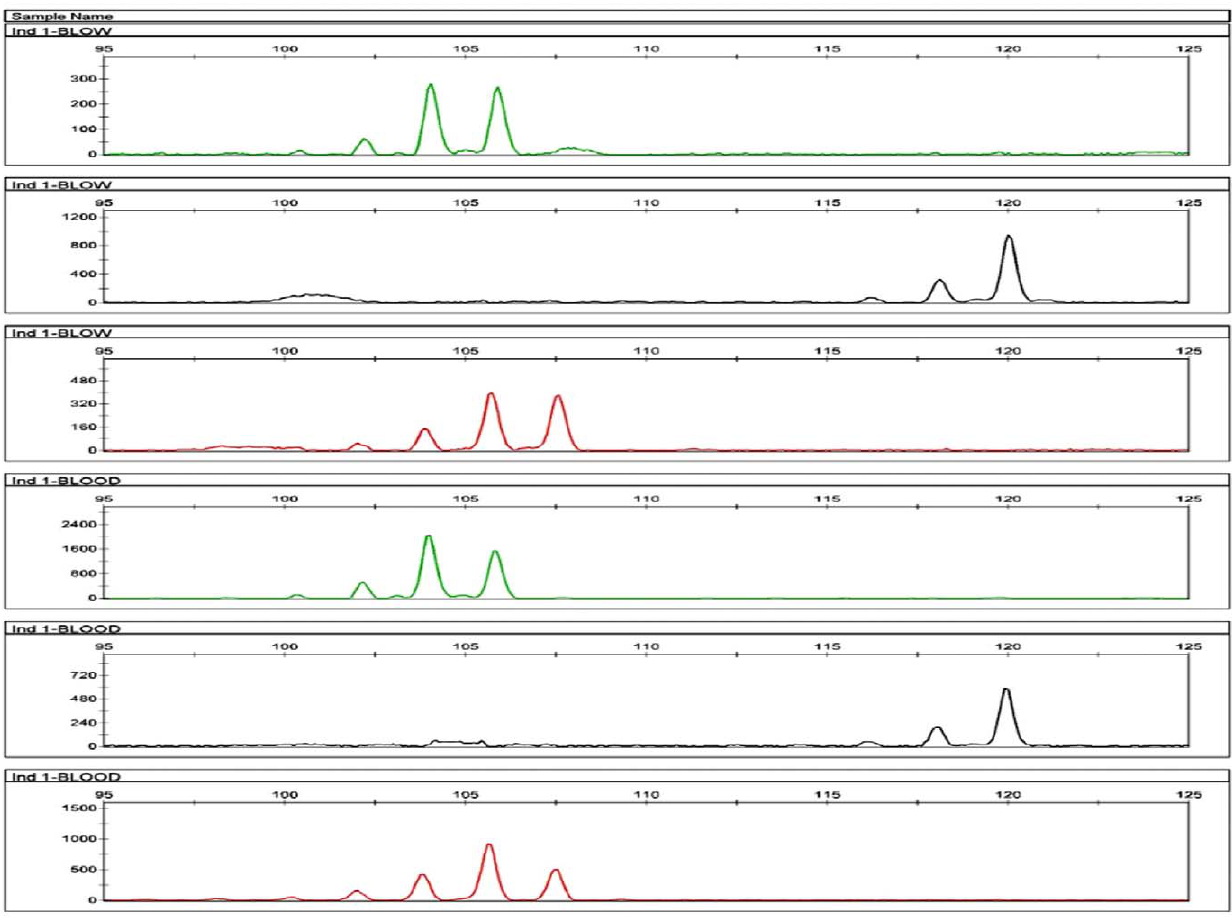
Figure 2. Microsatellite DNA profile of blow and blood from individual 1. To estimate whether the microsatellite profile collected from an individual’s blow matched the microsatellite profile collected from its blood, we amplified 3 polymorphic dinucleotide microsatellite loci: Lobs_Di9 (black), Lobs-Di19 (red), and Lobs_Di21 (green) [24]. The three loci were amplified using a Qiagen Multiplex KitTM (Qiagen). The annealing temperature was set at 53 u C for 60 seconds for a total of 30 cycles. PCR products were then run on an ABI 3730 DNA Sequencer (Applied Biosystems). Microsatellite profiles were visualised using the software GeneMapper (version 4.0). For ease of presentation, we only include here a figure showing the microsatellite DNA profile of blood and blow for one individual. The remaining 5 microsatellite DNA profiles are included in supporting online information Figure S1. The top 3 panels represent the three microsatellite loci amplified from DNA extracted from blow.